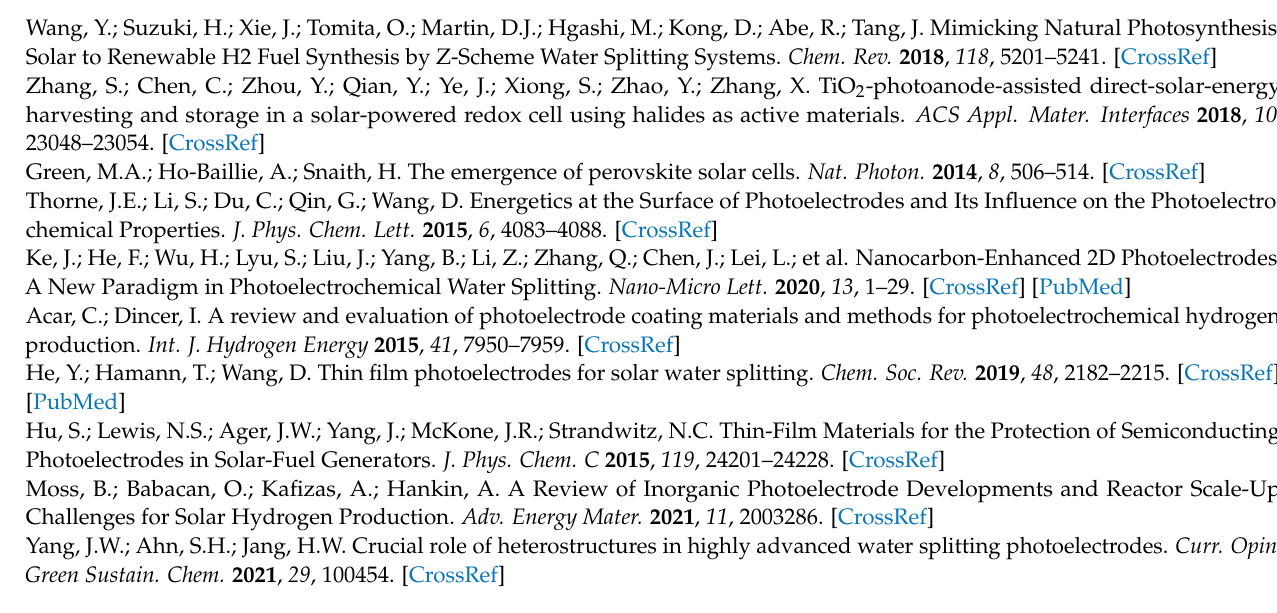
Mxene sheets; Figure S2: Stages involved in the fabrication of Mxene modified Mesoporous Titania Photoelectrodes; Figure S3: The EDS spectra and colorful elemental maps of Ti 3 AlC 2 precursor exhibit the contents of Ti, C and Al elements indicating good purity level of the utilized Ti 3 AlC 2 MAX phase as precursor; Figure S4: Successful production of the exfoliated and lamellar Ti 3 C 2 due to HF etching of Ti 3 AlC 2 in a controlled environment, with Ti, C, O and F as the main components indicated in EDS spectra; Figure S5: A pictorial view of Mxene functionalized mesoporous TiO 2 layer working as photoelectrode under light